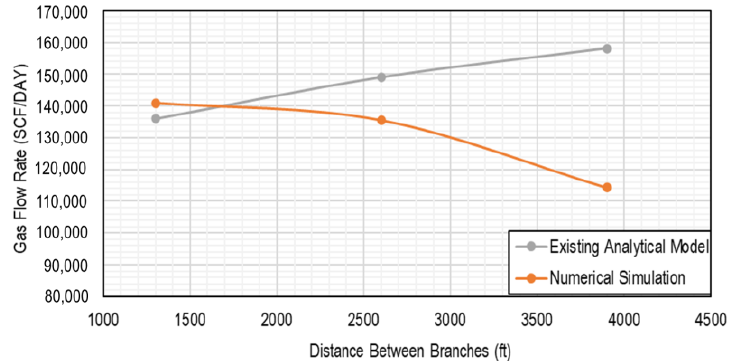
Figure 5. The effect of the length of branches on the cumulative gas production.